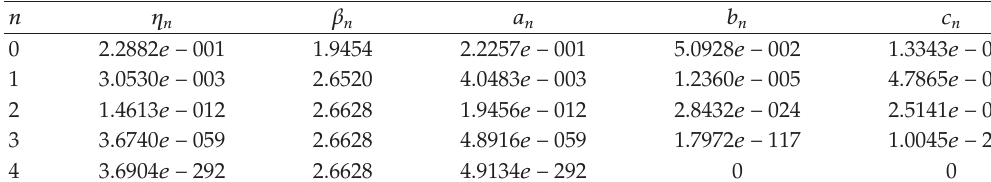
Table 1: Results of recurrence